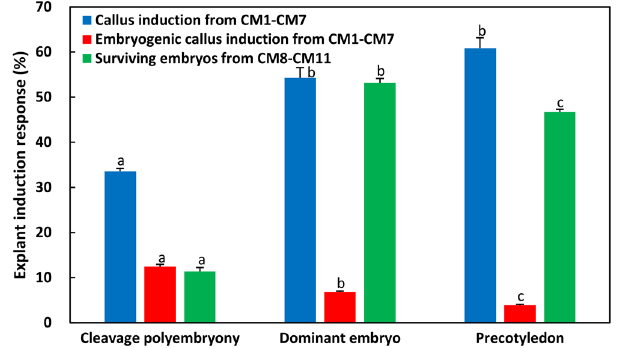
Figure 3. Effects of the three embryo developmental stages on embryogenic tissue induction. Cleavage polyembryony-, dominant-, and precotyledon-stage embryos were cultured in embryogenic tissue induction media CM1–CM11 for 6 weeks, after which, the rates of callus (represented by blue columns) and ESM (represented by red columns) induction from CM1–CM7 and the survival rate of embryos (represented by green columns) from CM8–CM11 were determined. Duncan's new multiple range test was used to detect differences at P <